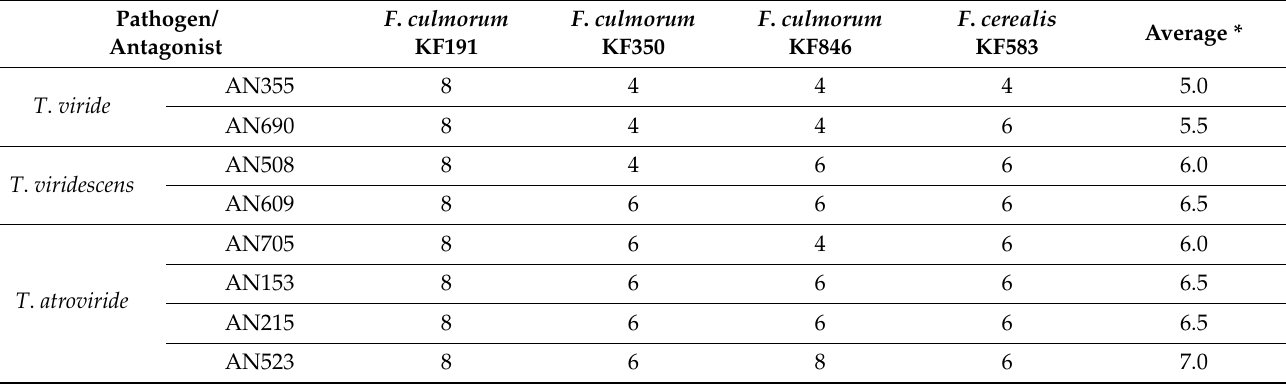
Table 2. The assessment of the interaction between Trichoderma vs. Fusarium colonies after 5 days of co-culturing on PDA medium.